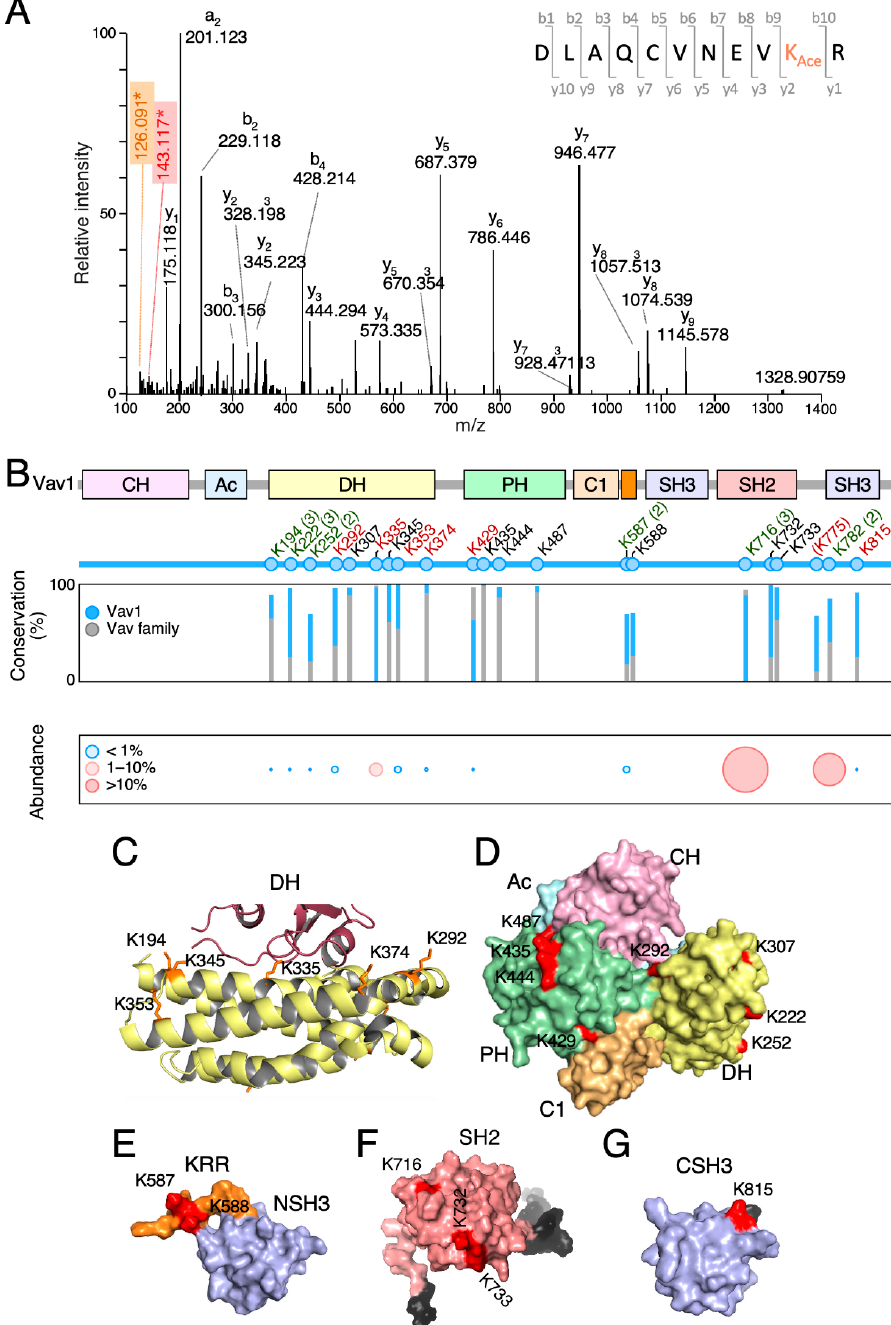
Figure 2. Vav1 is acetylated on multiple lysine residues. ( A ) Example of the tandem mass spectrometry spectrum of a peptide DLAQCVNEVK 374Ace R containing the acetylated (Ace) Lys 374 residue. The plot shows the acetylated lysine immonium ion at mass-to-charge (m/z) ratio of 143 (red box) and its derivative displaying an m/z ratio of 126 (brown box, generated by loss of ammonia). ( B ) Top, main Vav1 lysine acetylation sites identified by mass spectrometry. The new acetylation sites found in our study are shown in red. Residues found in our study and previous reports are indicated in green. The number of times in which these acetylation sites has been detected before this study is shown in brackets. If only once, the number is not indicated. Previously identified residues that were not found in our analyses are indicated in black. Lys 775 (shown between round brackets) is not conserved in